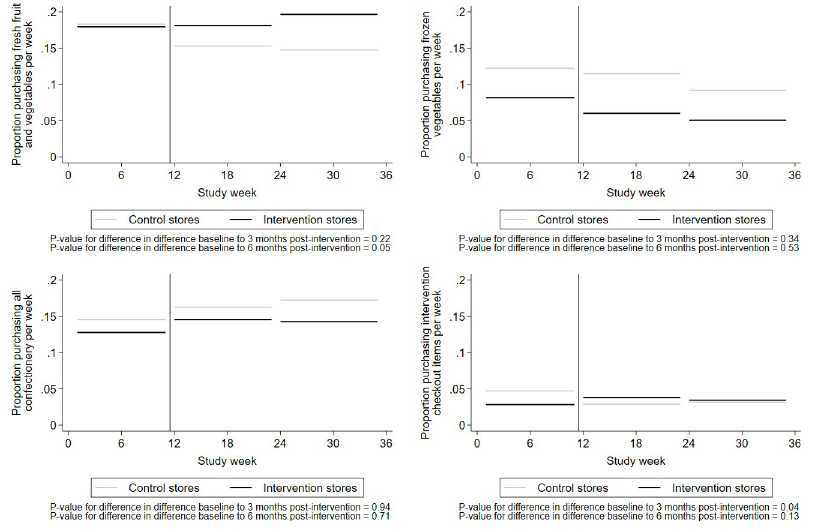
Fig 3. Modelled proportion of women purchasing food items in intervention and control